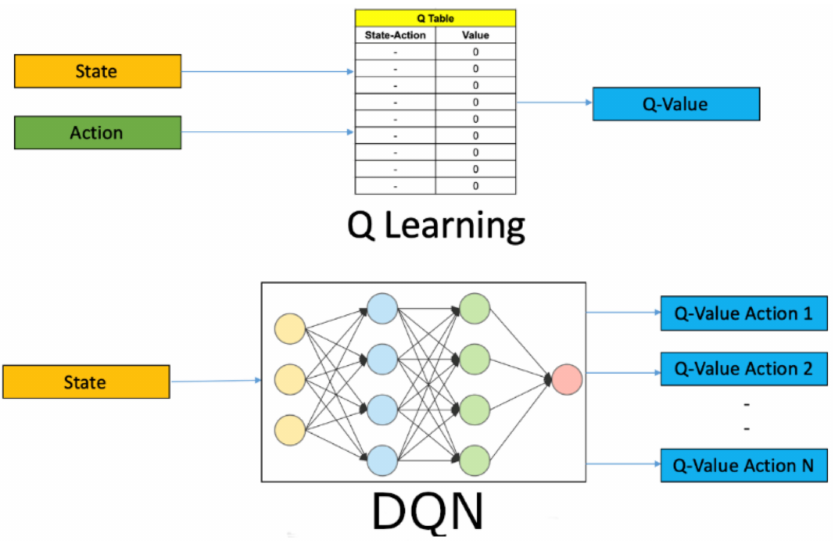
Figure 1. Q-learning vs. DQN.